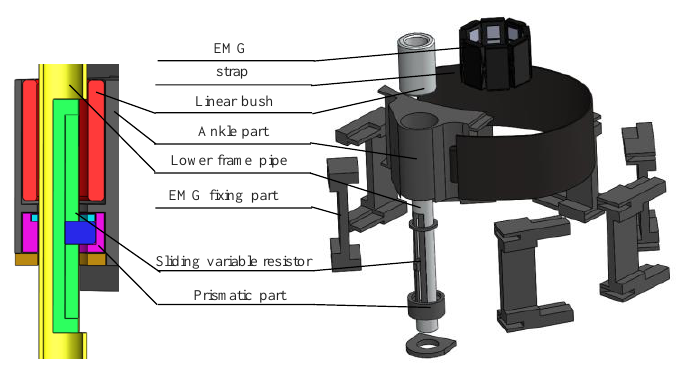
Figure 3. Exploded diagram to explain the ankle variable section.